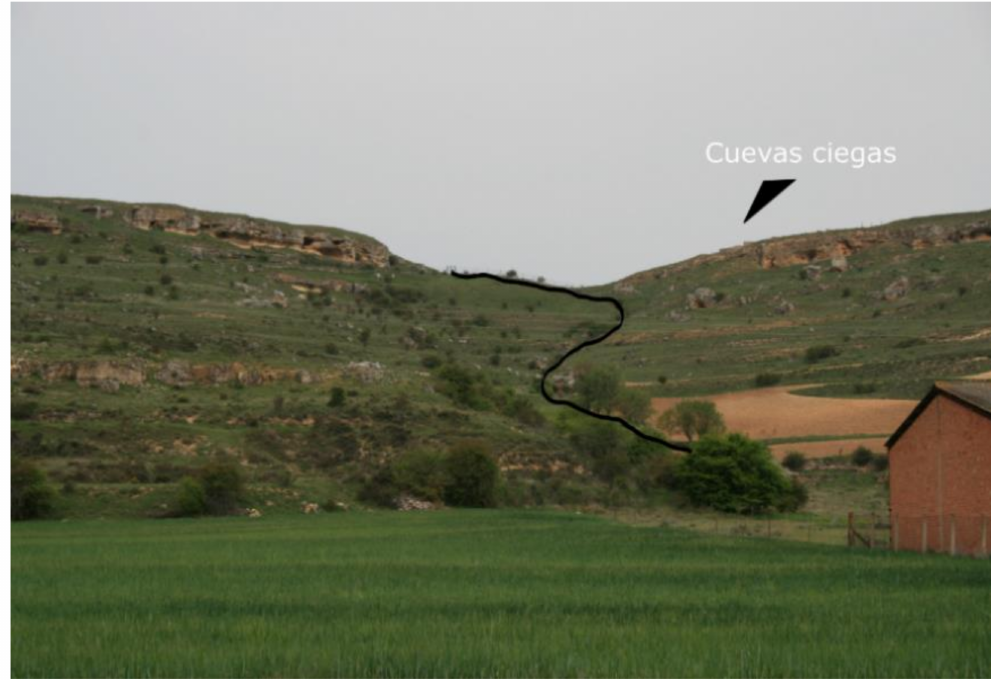
Figure 14. Detailed photo with a black-line indication of the scrapping